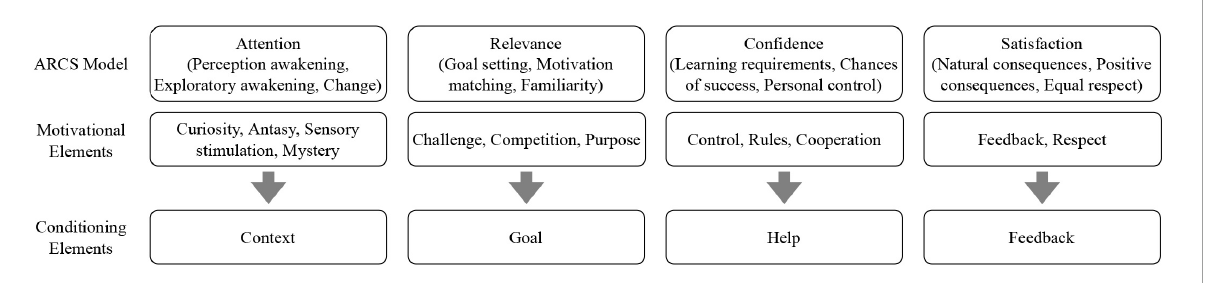
FIGURE1 Design of reconciliation elements.